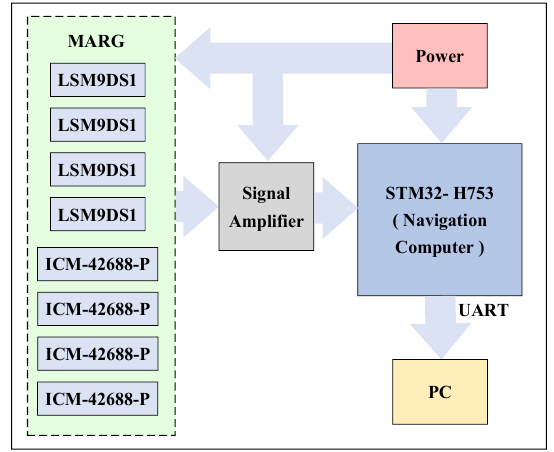
Figure 4. Block diagram of the hardware design.